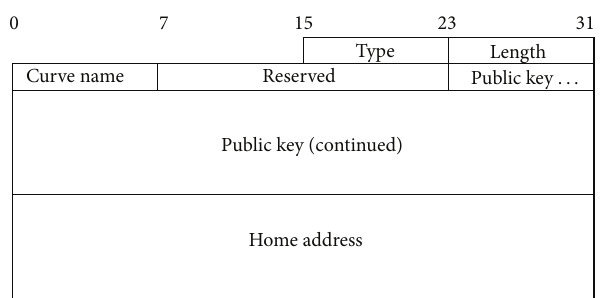
Figure 4: Node status request and response messages header format.